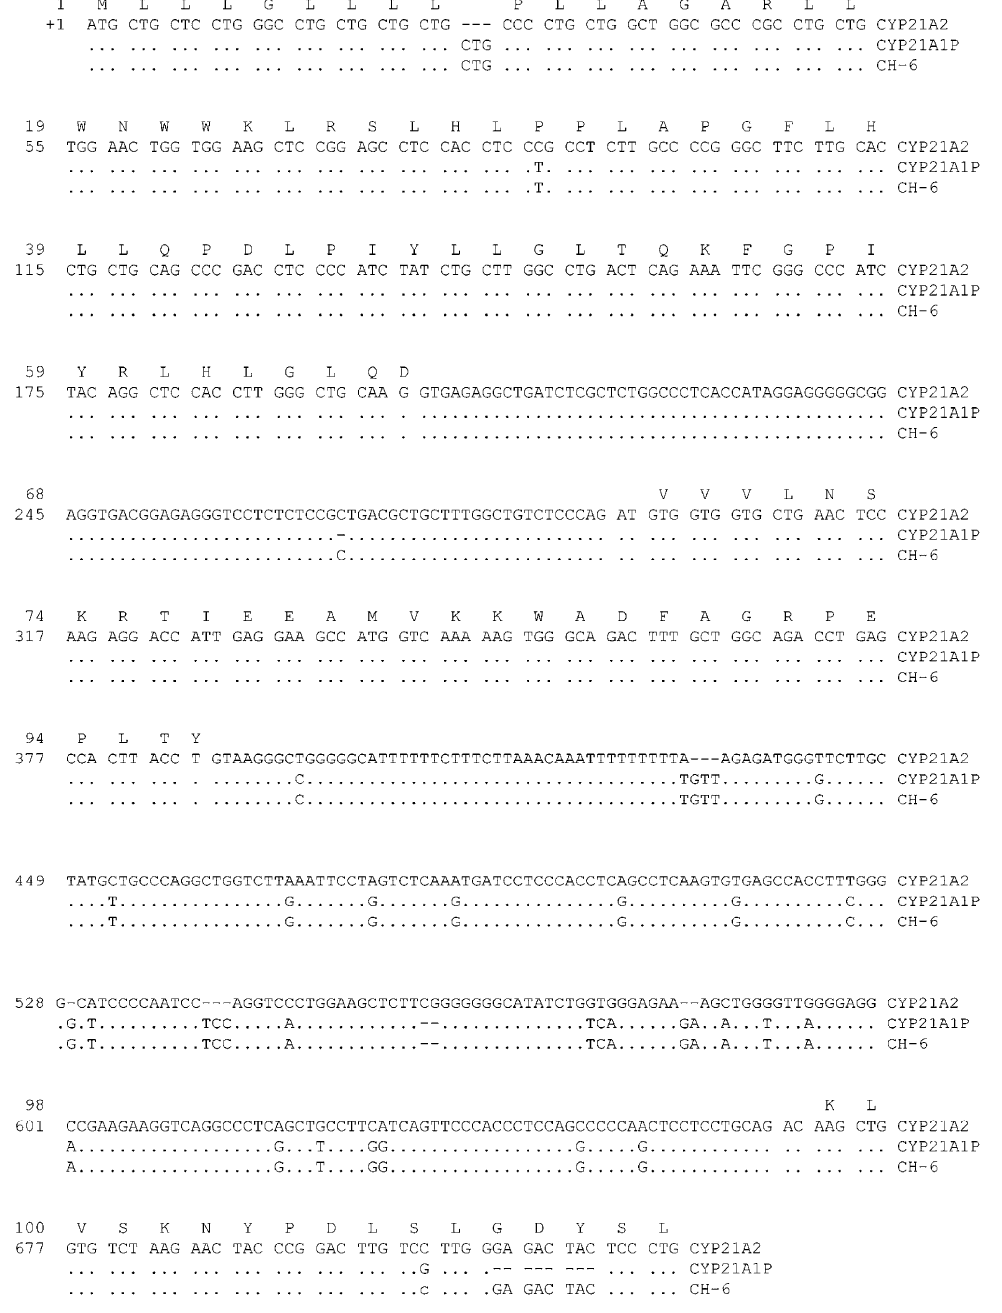
Figure 2 Sequence of the new chimeric gene . Sequence of CH-6 chimera from +1 nucleotide (exon 1) to +721 nucleotide (exon 3). Nucleotides were numbered starting from ATG. The lines showed: the amino acid sequence of CYP21A2 gene (M13936), the CYP21A2 nucleotide sequence (M13936), the CYP21A1P nucleotide sequence (M13935) and the CH-6 nucleotide sequence. Only nucleotide differences between CYP21A1P or CH-6 and CYP21A2 active gene are shown under corresponding nucleotides in CYP21A2